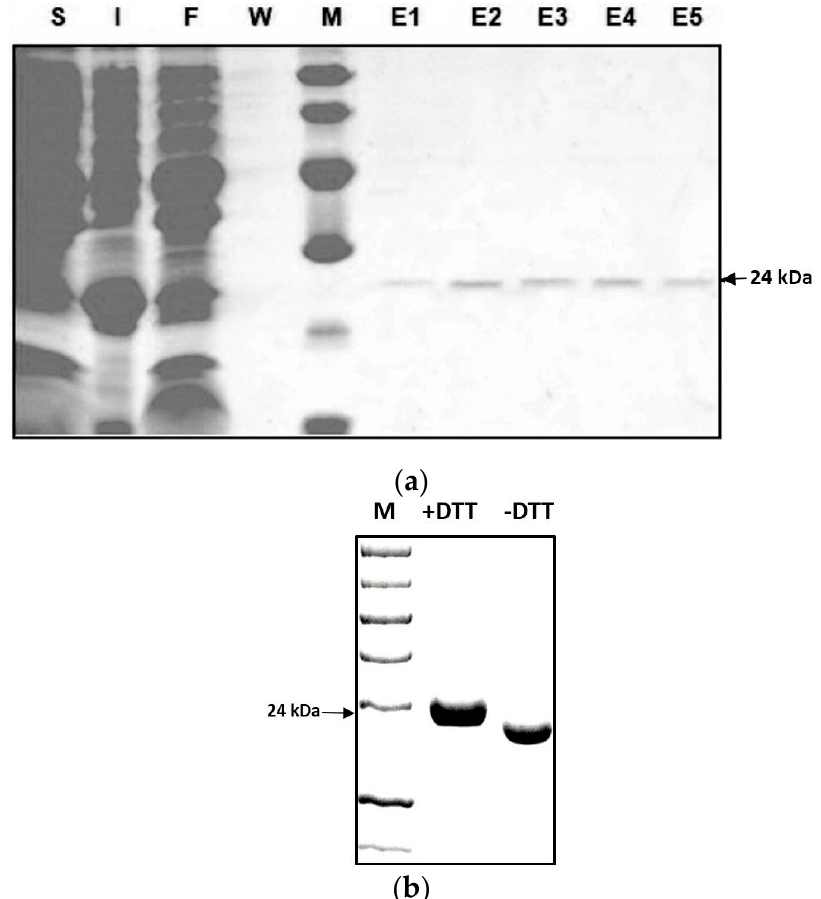
Figure 3. ( a ) SDS–PAGE of the recombinant Zm-INVINH4 protein in E.coli with a predicted mass of 24 kDa. Soluble proteins (S); insoluble proteins (I); flow-through of the column (F); wash fraction (W); and elution (E1–5). ( b ) The increased mobility of the recombinant Zm-INVINH4 protein during gel electrophoresis in the absence of a reductant, as compared with the reductant (DTT)-containing sample buffer, which indicates that the active conformation forms a rather compact structure.